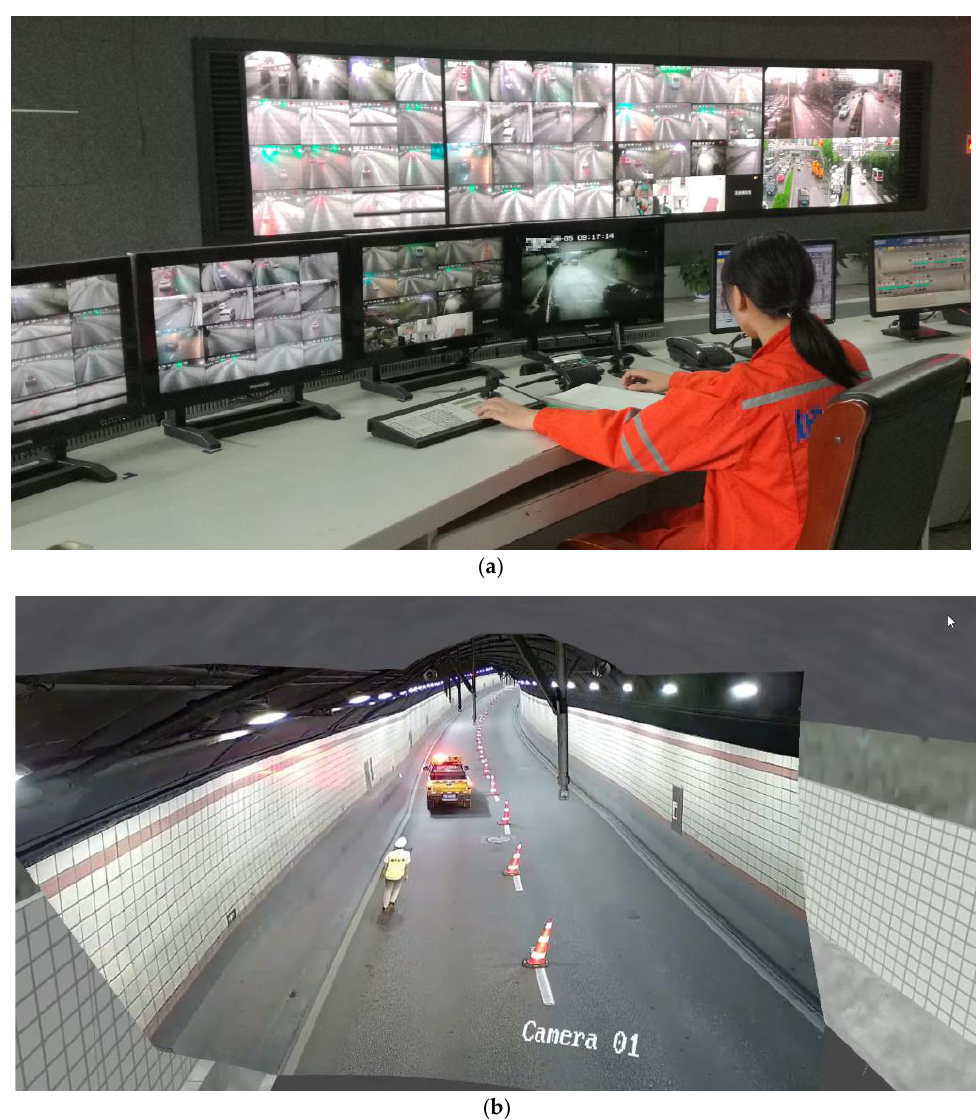
Figure 17. Comparison of tunnel inspection effect before and after demonstration: ( a ) Ball camera manual inspection; ( b ) automated 3D video patrol.